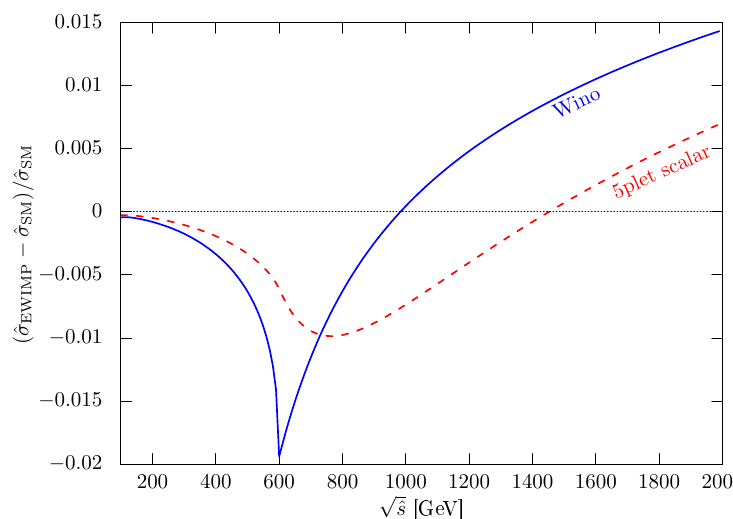
Figure 2 . The EWIMP correction to the partonic cross section. The blue and solid line shows the corrections from the 300 GeV Wino ( n = 3, Majorana fermion) and red and dashed 300 GeV 5plet real